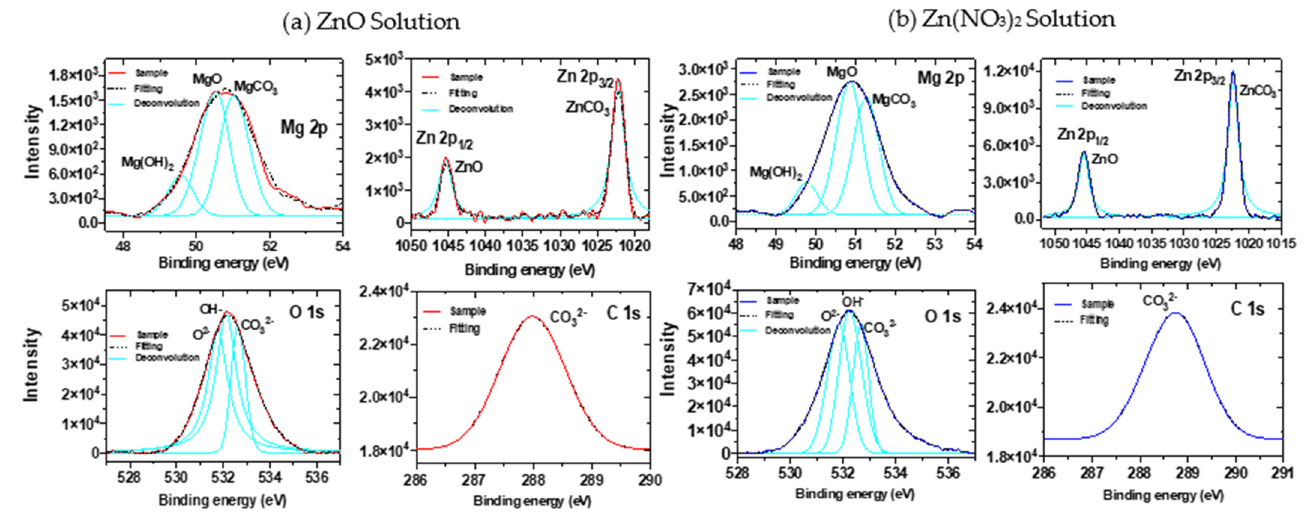
Figure 3. XPS spectra of ZnO electroless deposits on Mg–Ca0.3, obtained from 10 − 3 M aqueous solutions (at 21 °C): ( a ) ZnO and ( b ) Zn(NO 3 ) 2 .